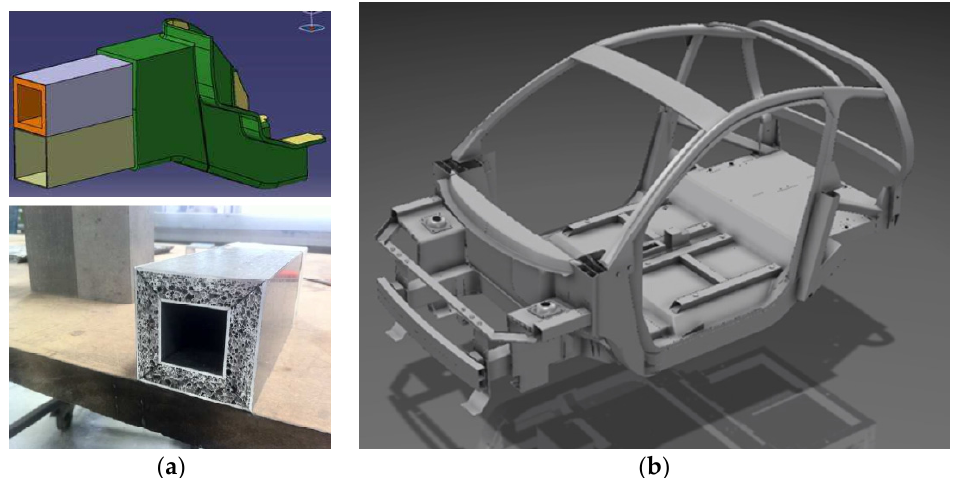
Figure 5. ( a ) Crash absorber box of the electric car prototype in the frame of the European project Evolution made with rectangular Al-profiles filled with Al-foam; and ( b ) CAD design of the body in white (courtesy of Cidaut, Valladolid, Spain, Pinningfarina, Cambiano, Italy and Pohltec metal foam, Collogne, Germany).